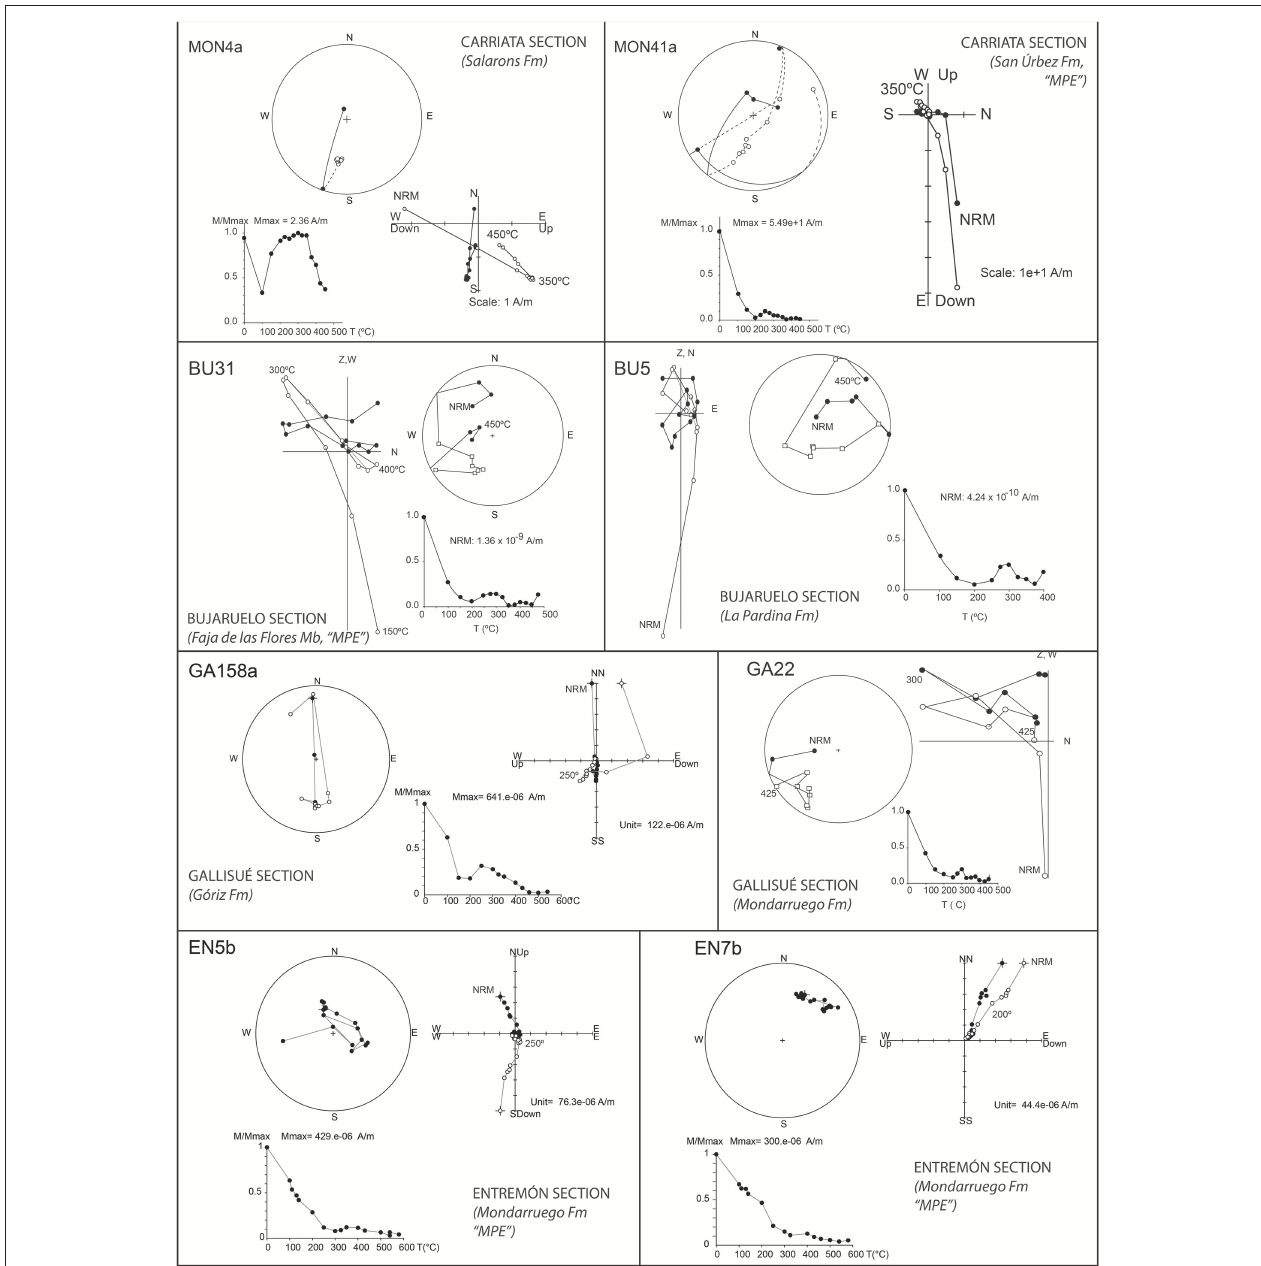
FIGURE 7 | Examples of thermal demagnetization diagrams in stereographic and orthogonal projections and NRM decay during the stepwise demagnetization procedure. Open (closed) symbols represent down (up) directions, respectively. “MPE”: magnetic properties excursion, marked by blue (gray) bars in Figure 8 ( Figure 9